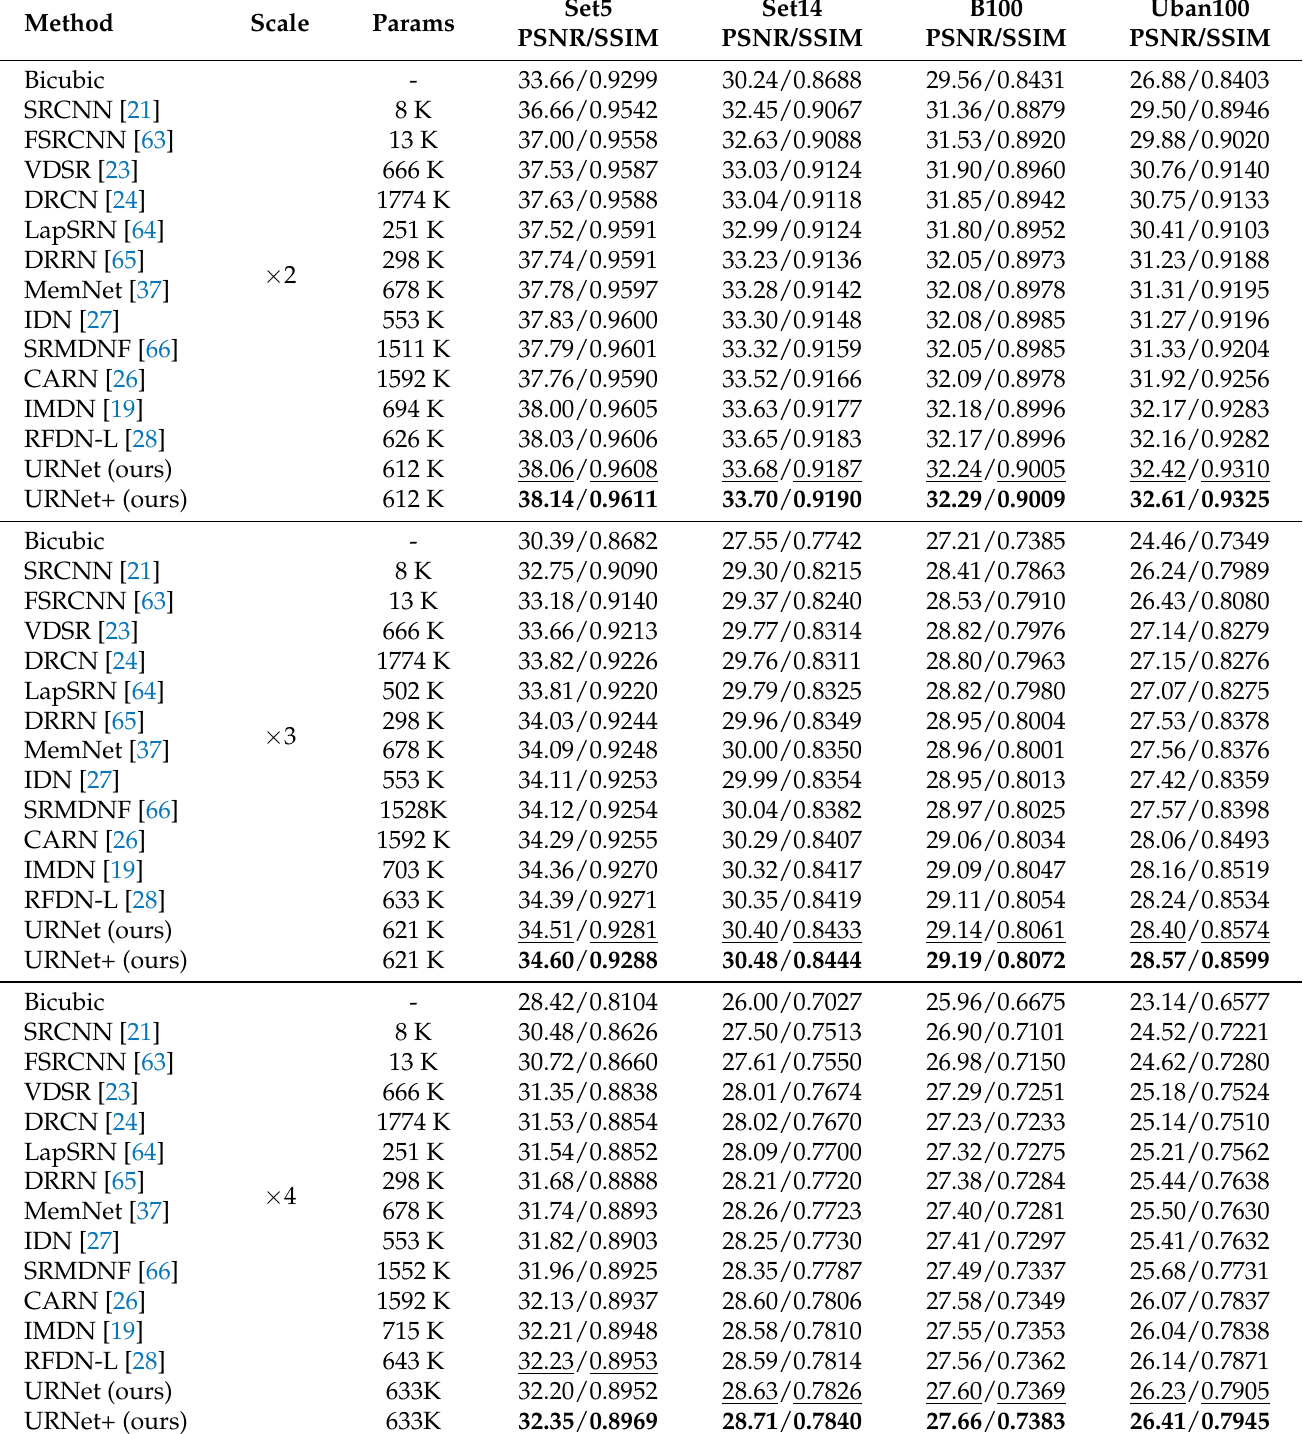
Table 4. The average performance of the state-of-the-art methods for scale factor × 2, × 3, and × 4 on the four benchmark datasets Set5, Set14, B100, and Urban100. Best and second best results are bolded and